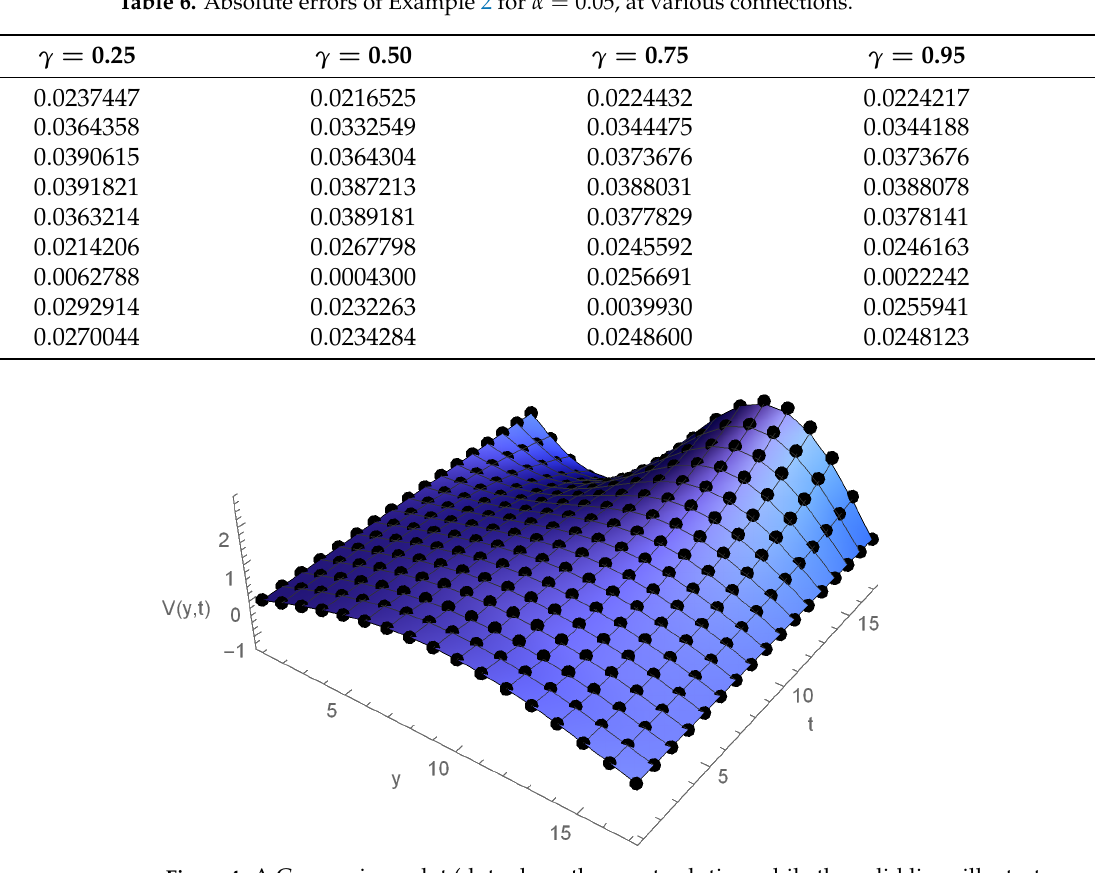
Table 5. The L 2 errors of Example 2 for α = 0.15, τ = 1